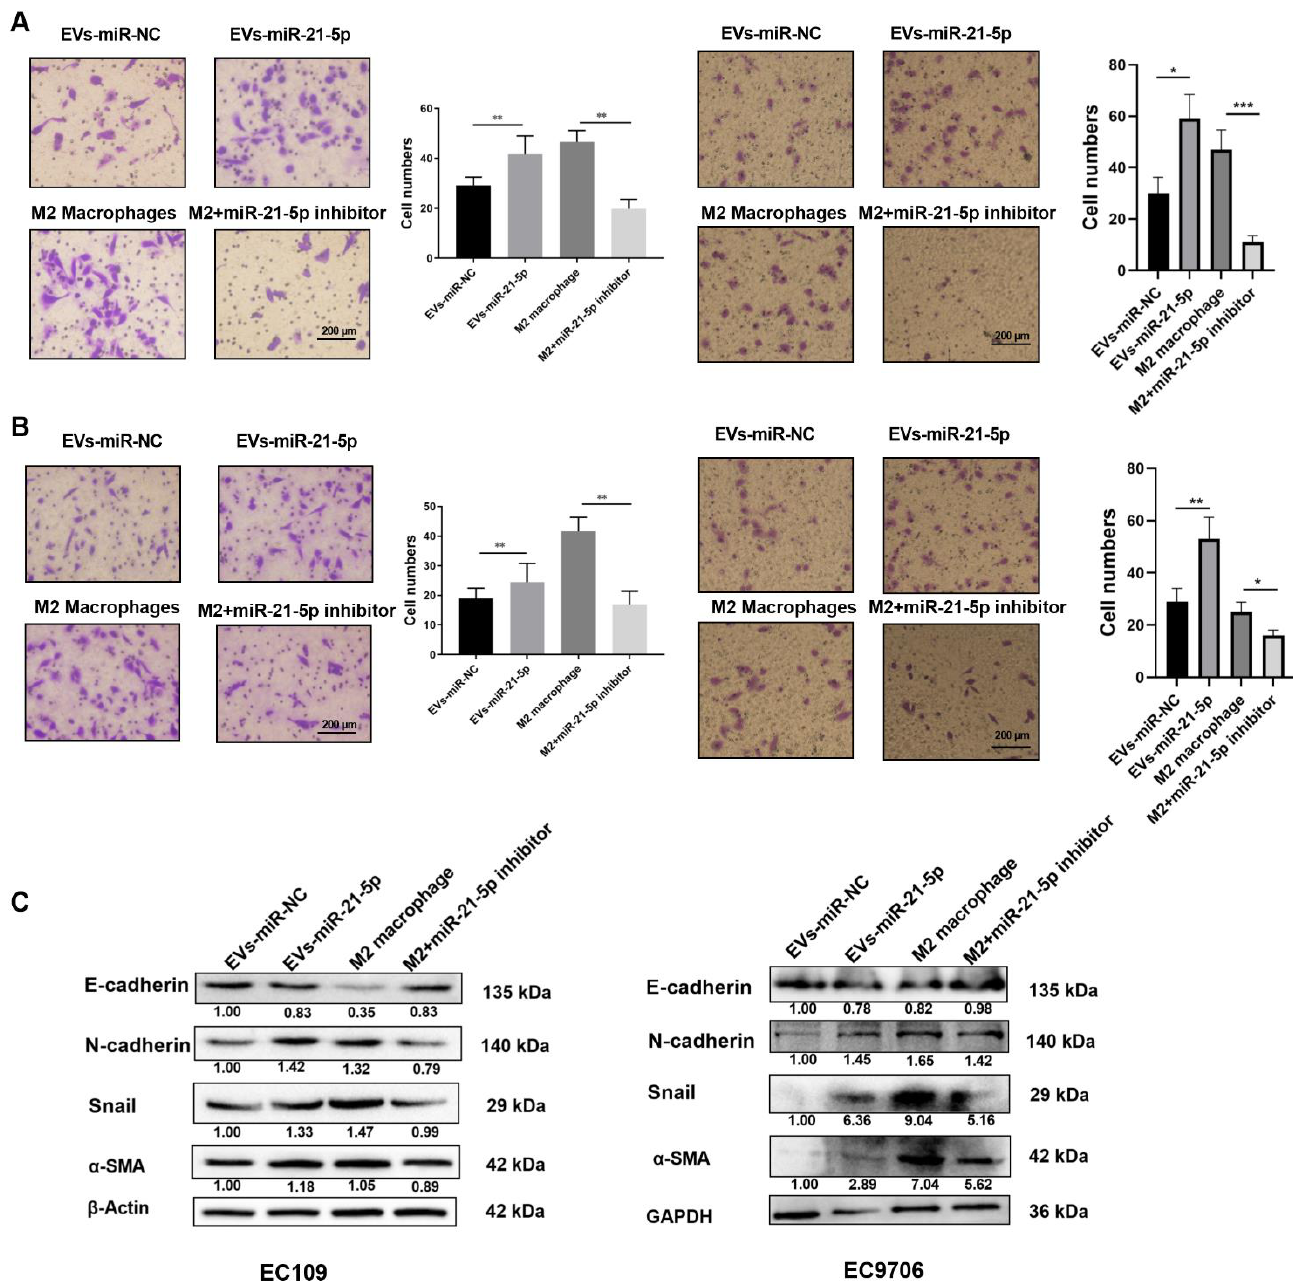
Figure 6. EVs-miR-21-5p regulates migration, invasion, and expression of EMT-related genes in EC109 and EC9706 cells. Representative images of a migration ( A ) and invasion ( B ) assay of EC109 and EC9706 cells that were cultured with the supernatants of miR-21-5p-overexpressing M0 macrophages or IL-4-induced macrophages transfected with a miRNA-21-5p inhibitor. ( C ) Western blotting analysis of N-cadherin, E-cadherin, Snail and α -SMA expression in EC109 and EC9706 cells. Values are expressed as means ± SD. The relative protein levels were normalized to β -actin or GAPDH. The F test was applied to assess statistical significance in group comparisons; * p < 0.05; ** p < 0.01, *** p < 0.001. Error bars indicate mean ± SD. The uncropped Western Blot images can be found in Supplementary